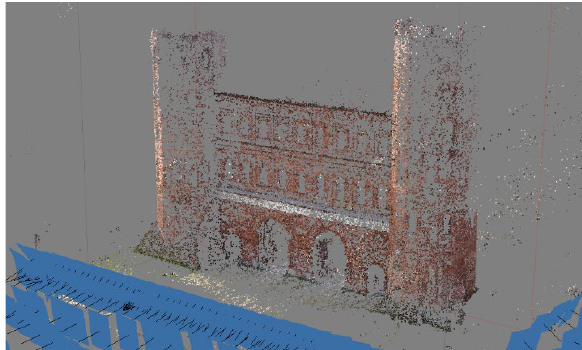
Figure 5 . Alignment of photographic shots and creation of the dense cloud with